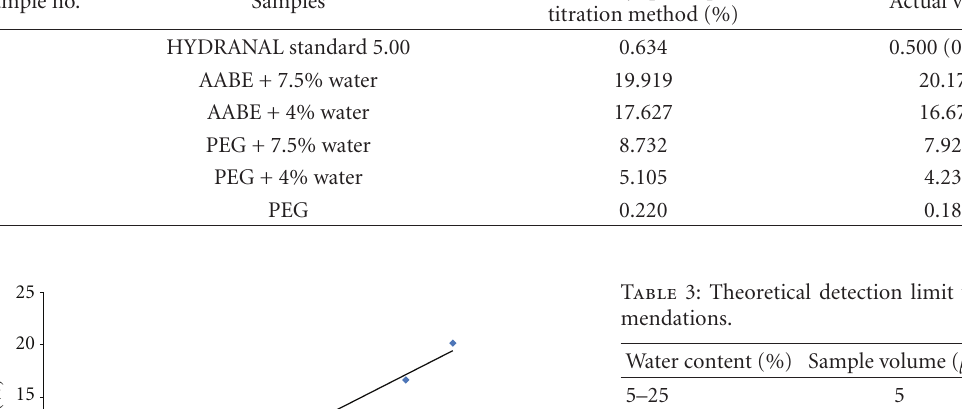
Table 2: Spectrophotometric method values and actual values of moisture in set of samples. Sample no.